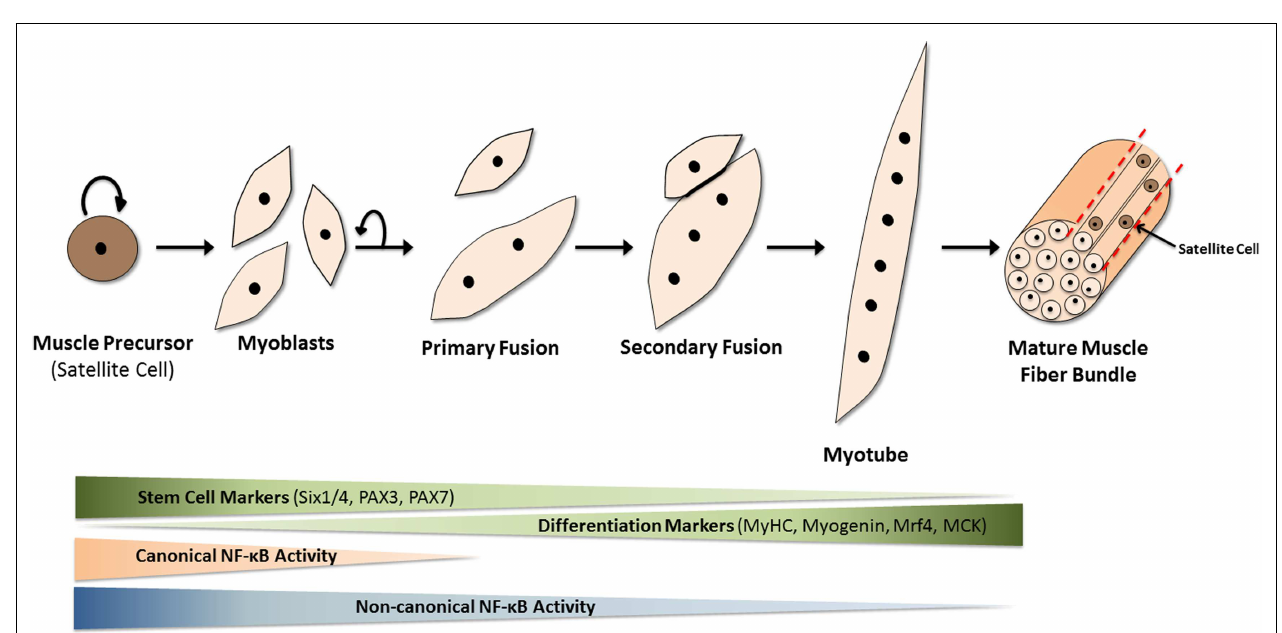
myogenesis, expression of stem cell markers such as Pax7 is gradually lost, while the appearance of differentiation markers, such as myosin heavy chain (MyHC), muscle-regulatory factor 4 (Mrf4), and muscle creatine kinase (MCK) gradually increases.The NF- κ B pathways are now known to play significant roles in this differentiation process.The canonical (or classical) NF- κ B pathway is needed for myogenic cell proliferation. However, upon the loss of canonical NF- κ B signaling and the activation of non-canonical (or alternative) NF- κ B signaling, myoblasts stop dividing and start fusing to form multinucleated myotubes, a key event in